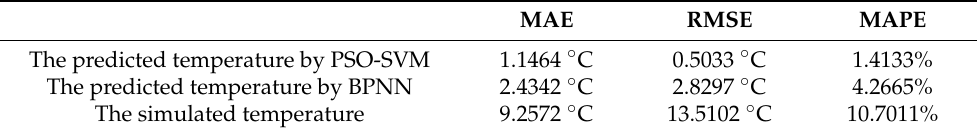
Figure 10. Comparison between the measured, predicted and simulated operating temperature of solar cell module #2. Table 4. Error analysis of the predicted and simulated temperature for solar cell module